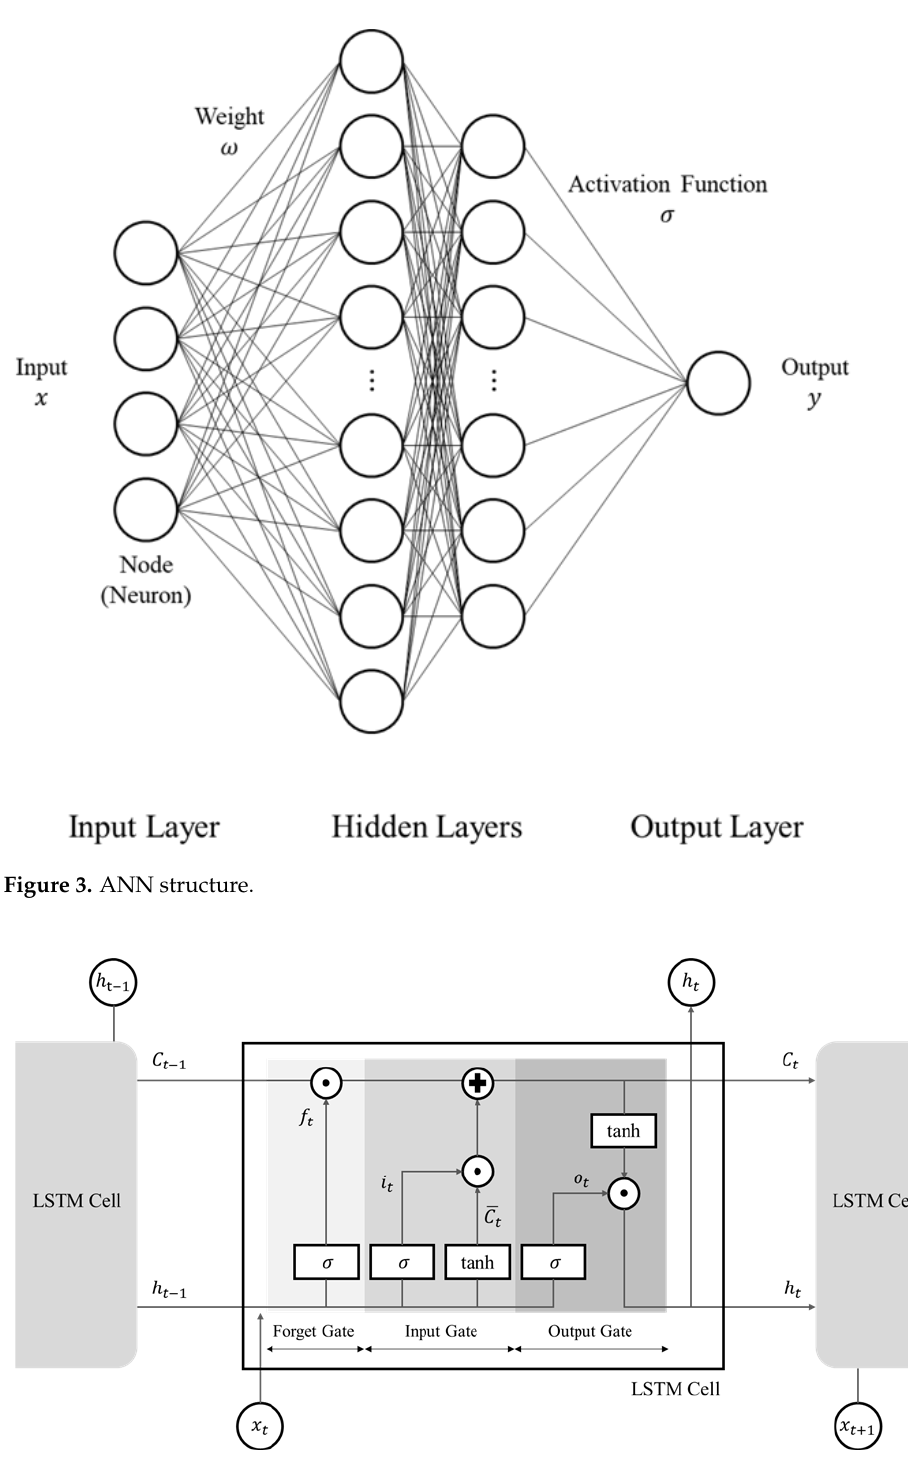
Figure 4. LSTM structure with a unit cell.